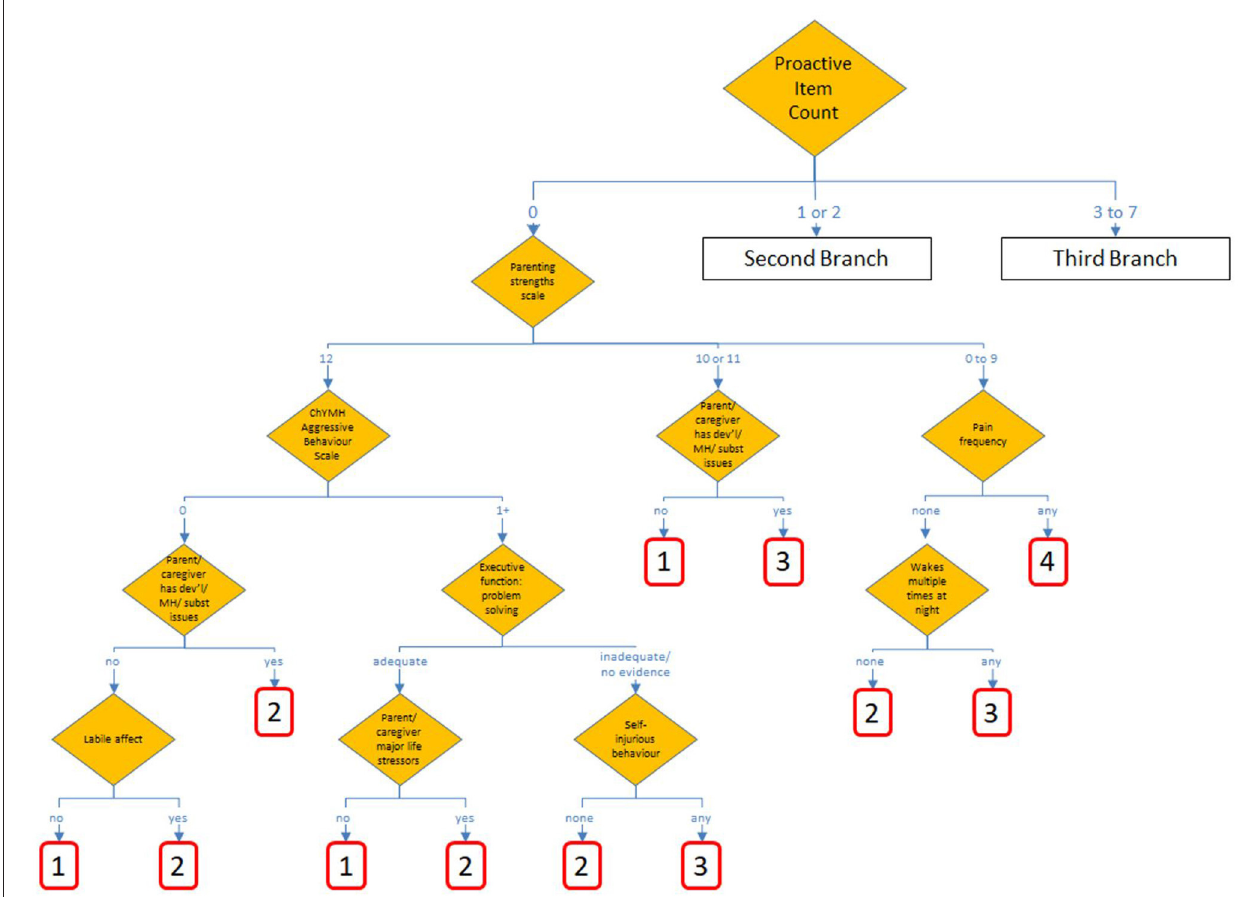
FIGURE 1 | First branch of ChYMH Caregiver Distress Tree